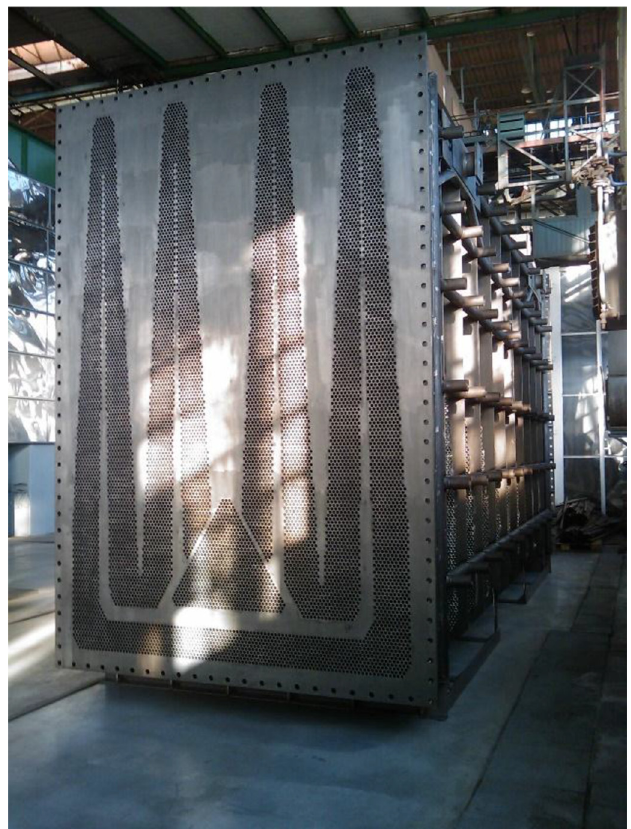
Fig. 1. Heat exchanger with sieve tray.